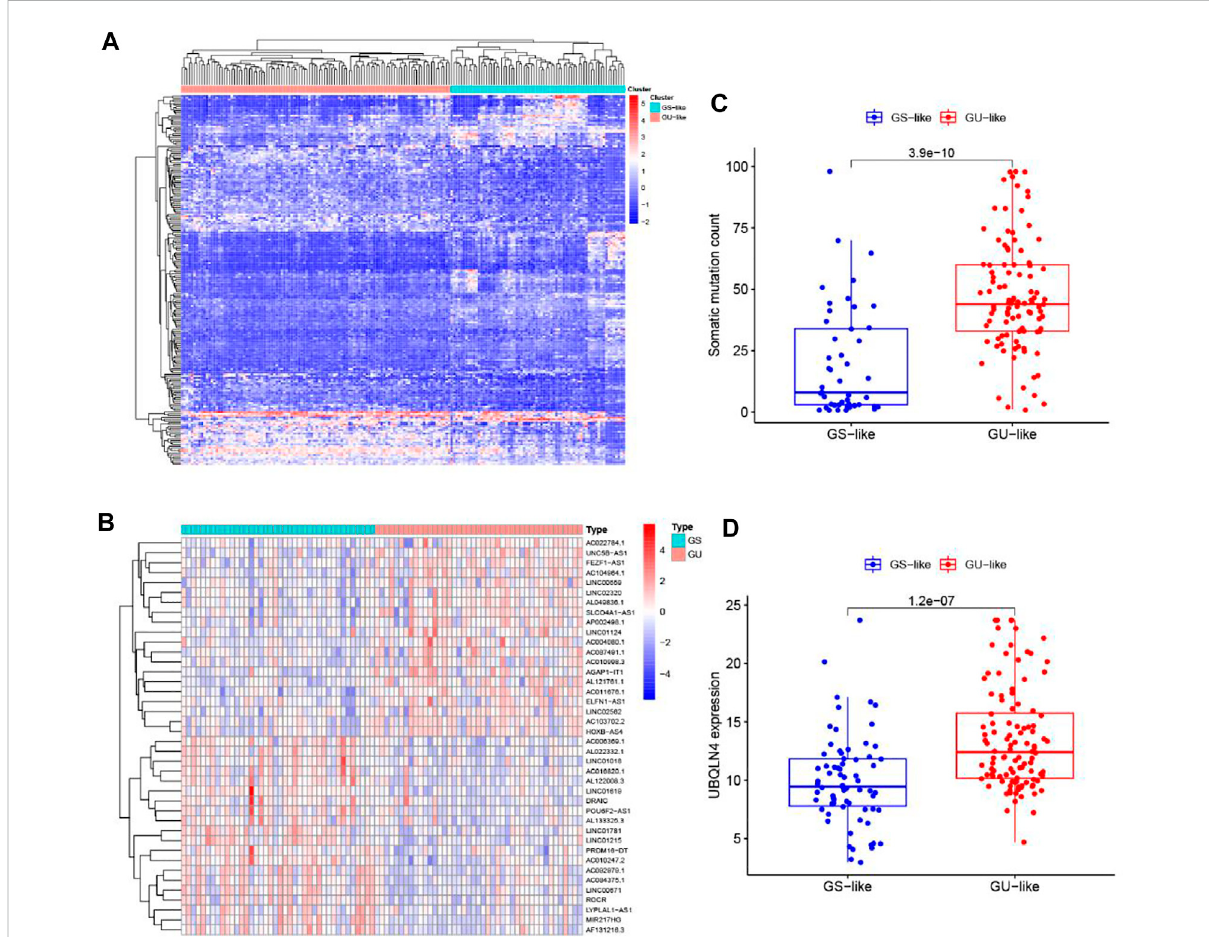
FIGURE 2 Identi fi cation of genome instability-related lncRNAs in patients with pancreatic cancer. (A) Unsupervised clustering analysis of the lncRNA expression pro fi les in the GU group and GS group. (B) Unsupervised clustering analysis of 171 patients with pancreatic cancer according to the differential expression patterns of 206 GILnc. (C) Boxplots of somatic mutations count in the GU-like group and GS-like group. (D) Boxplot of the expression level of UBQLN4 in the GU-like group and GS-like